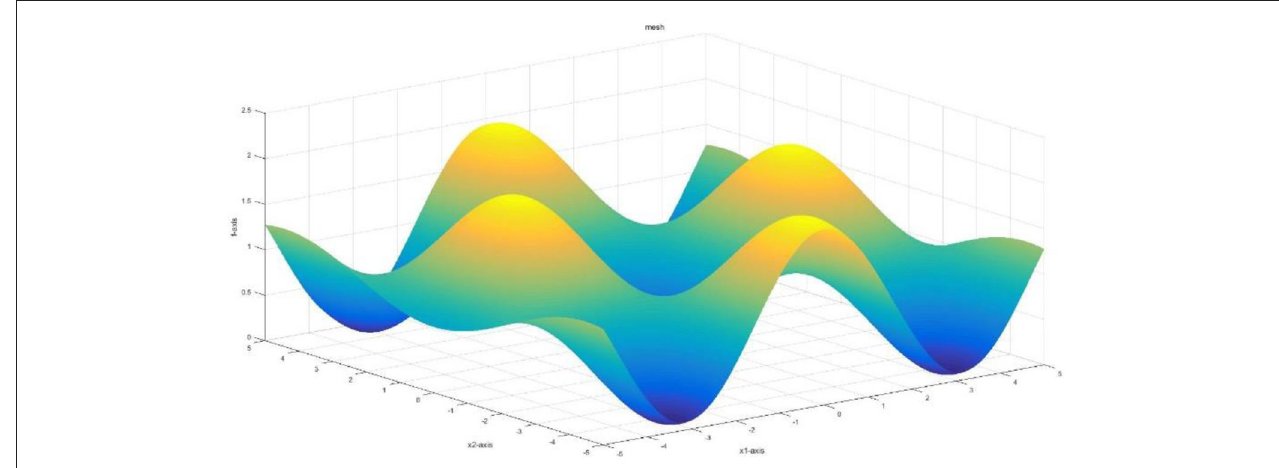
FIGURE 7 | The image of the Griewangk function.